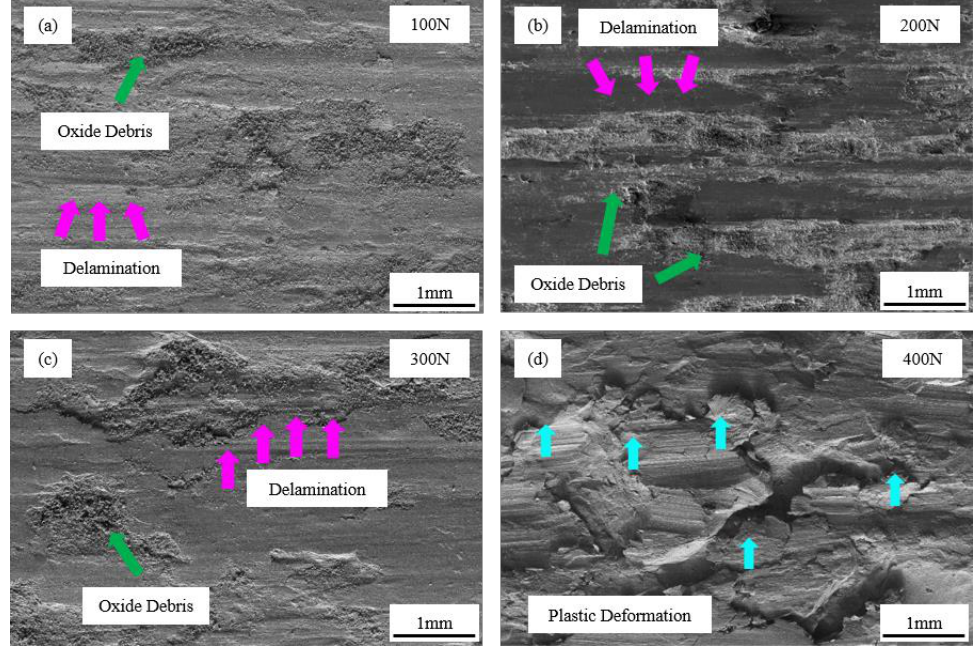
Figure 9. Worn surface morphologies of FeCrSiNiCoC coating at ( a ) 100 N, ( b ) 200 N, ( c ) 300 N, and ( d ) 400 N.